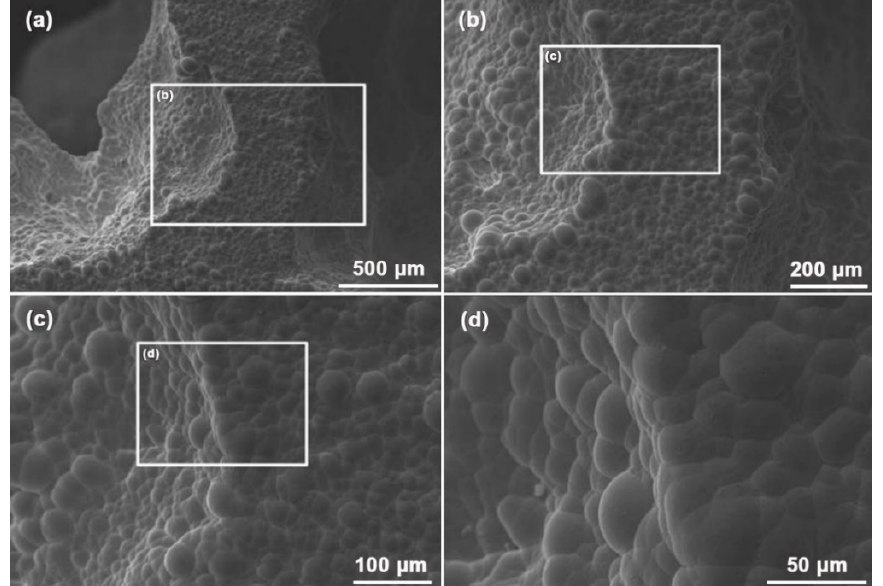
Figure 2. Microstructure of AZ91D hybrid foams: ( a ) single strut. ( b ) enlarged image in the box marked in ( a ) that showing uniform distribution of coating. ( c ) enlarged image in the box marked in ( b ) that displaying nodular morphology of EN layer. ( d ) enlarged image in the box marked in ( c ) that showing the detail of nodular morphology.